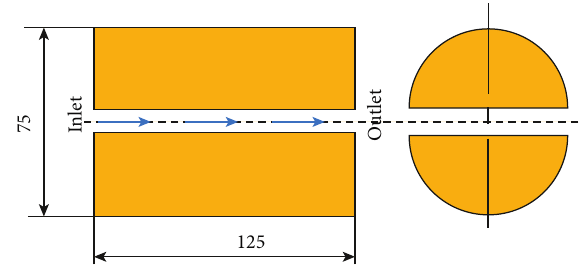
Figure 2: Fracture specimen.